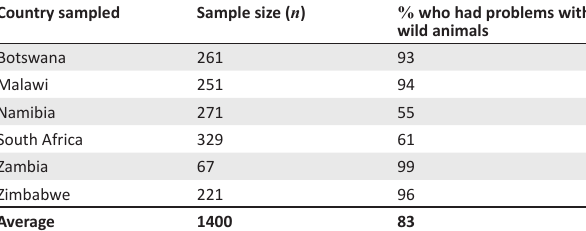
TABLE 6: Percentage of respondents who had problems with wild animals by location. Country sampled Sample size ( n